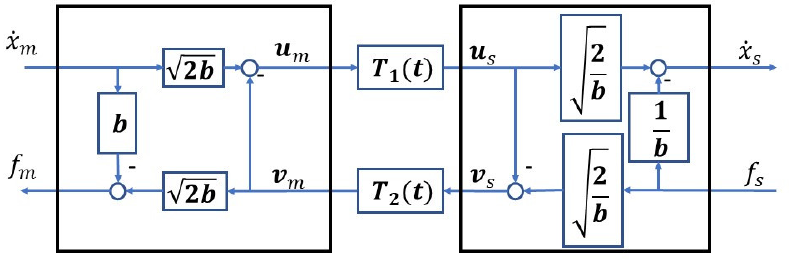
Figure 2. Wave variable transformations for communication link